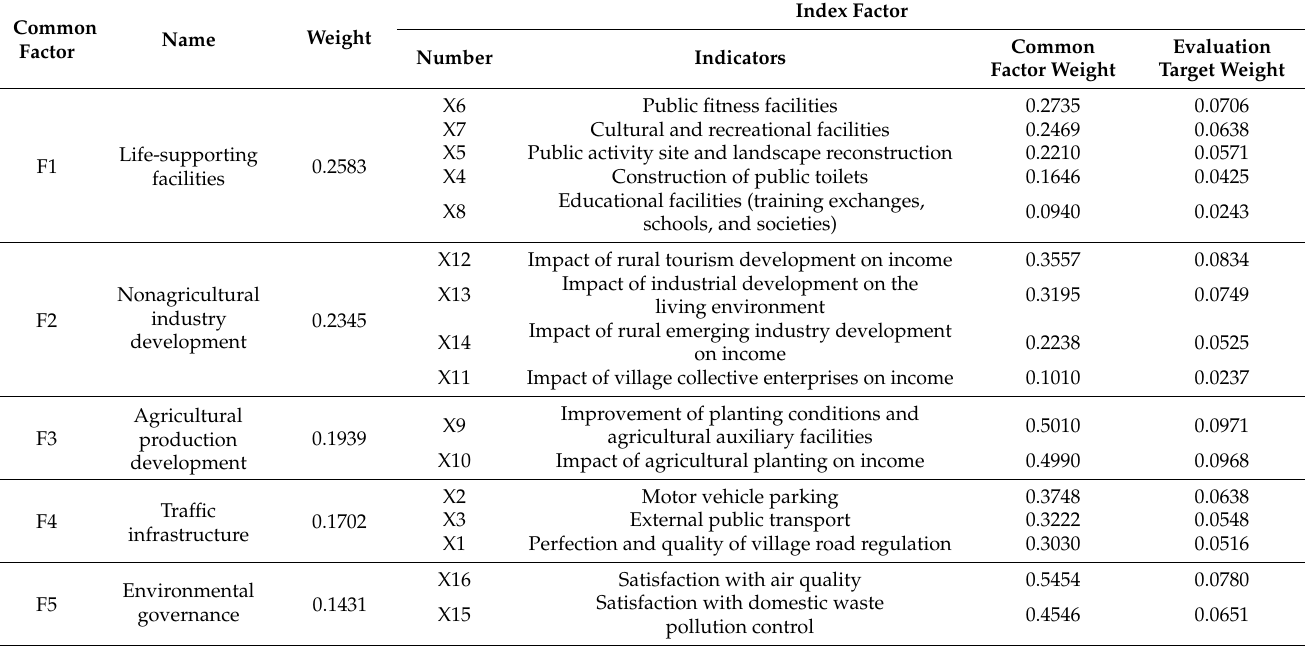
Table 4. Index system of satisfaction evaluation of rural human settlements based on empirical